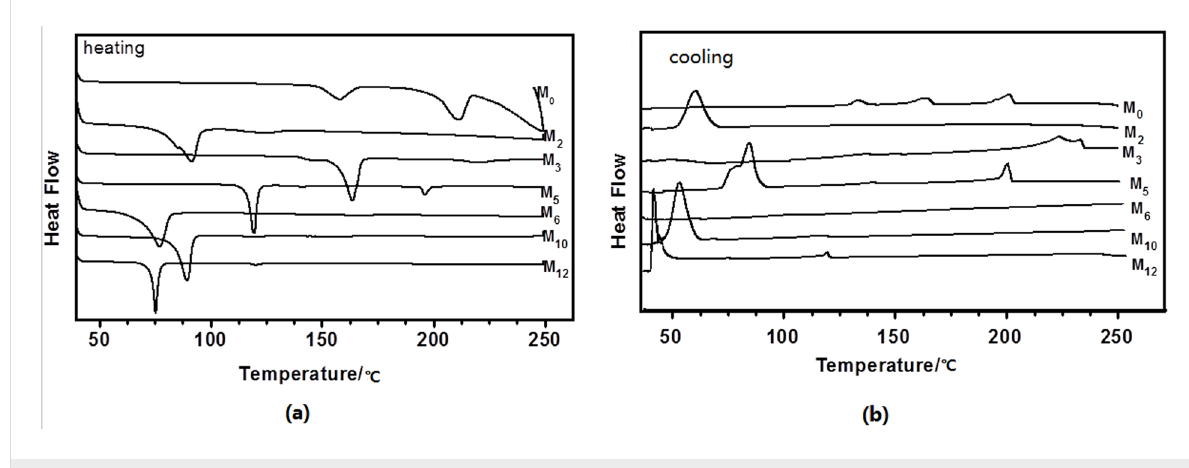
Figure 2: DSC thermogram of the compounds M 0-n obtained on (a) heating and (b) cooling.